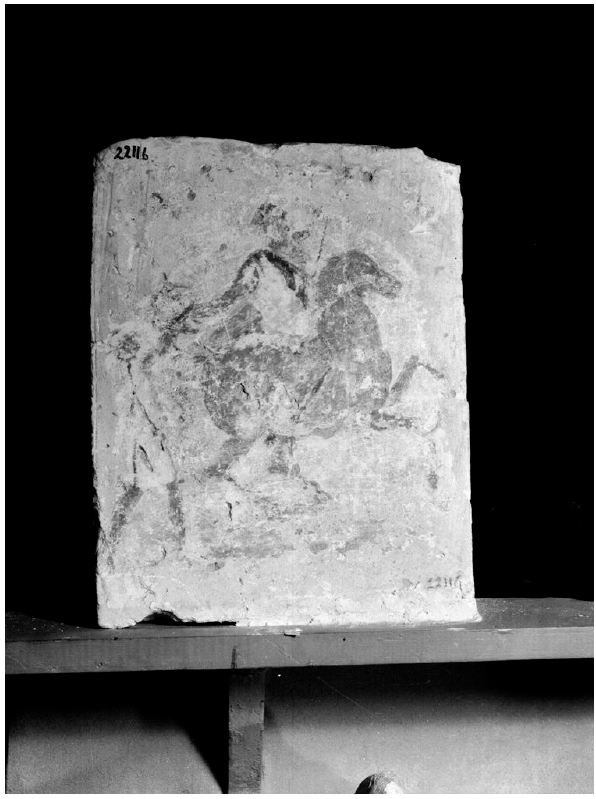
Figure 2. Funerary Stela of a Man on Horseback. Photograph courtesy of Kyriakos Savvopoulos.